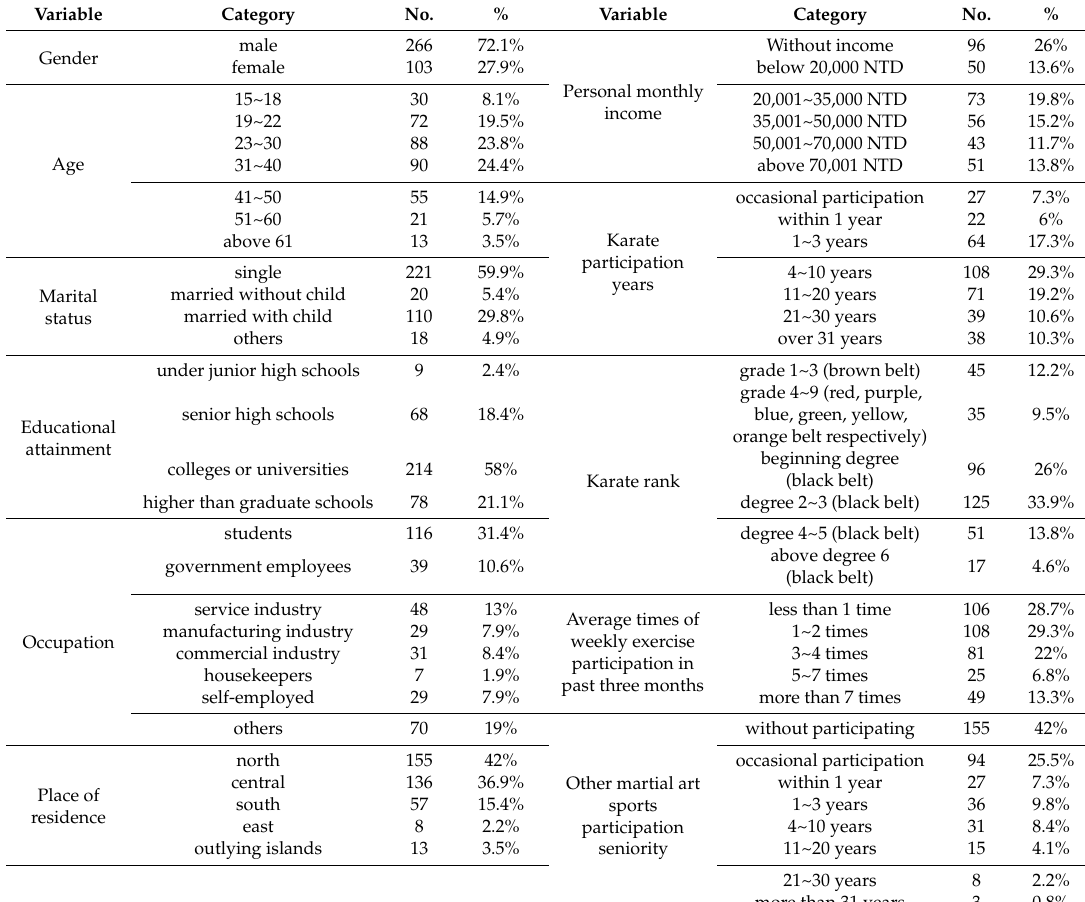
Table 1. Analysis of sample basic data.